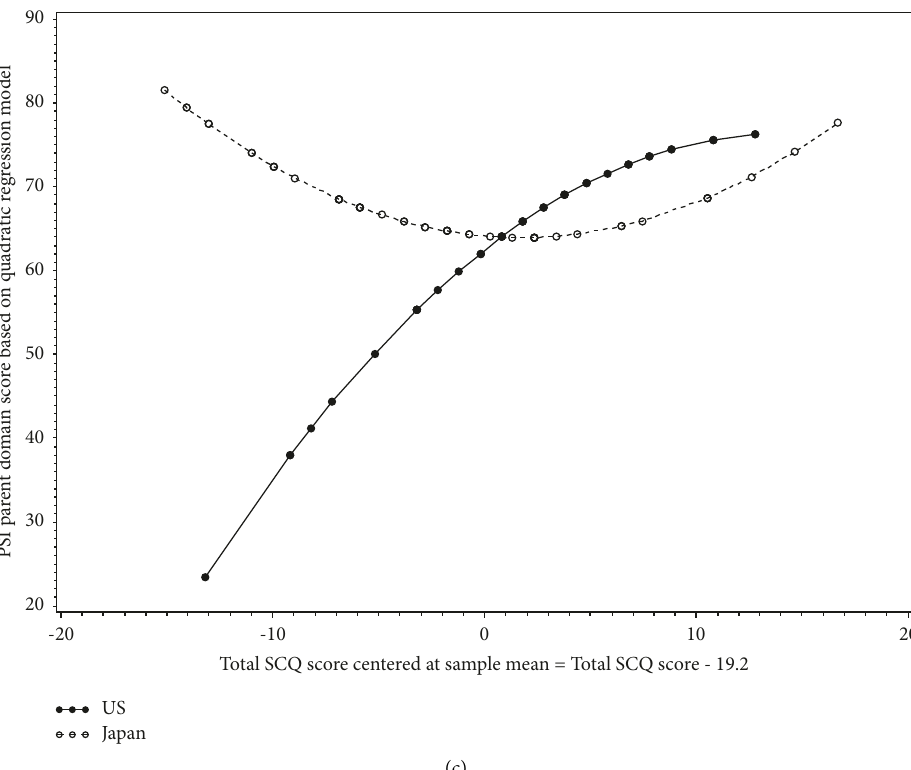
Figure 5: (a). Difference between the U.S. and Japan with respect to the quadratic association between parenting stress index (PSI) total score and the social communication questionnaire (SCQ) total score centered at sample mean. Note: (a) is a graphical display of the following fitted quadratic regression model: “mean (maternal stress level based on total parenting stress index score)” � “ 80.85+1.83 × (SCQ scores − 19.2) − 0.07 ×